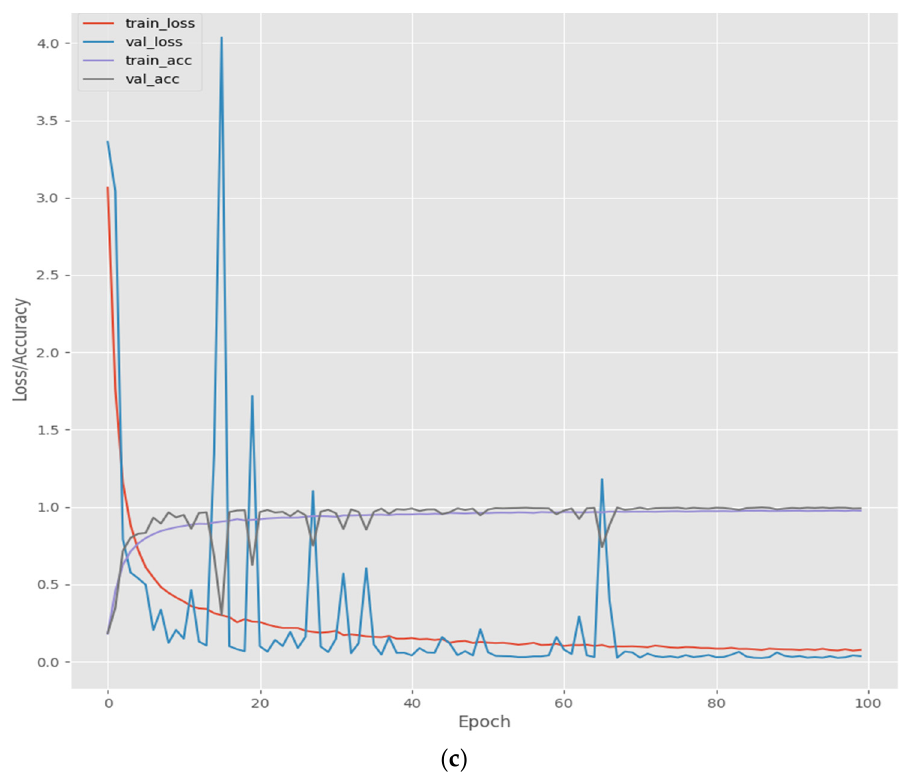
Figure 7. Analysis of proposed model at 100 epochs and a batch size of 30: ( a ) precision, recall, and F1 score for the 24 classes; ( b ) confusion matrix; ( c ) accuracy and loss curve.